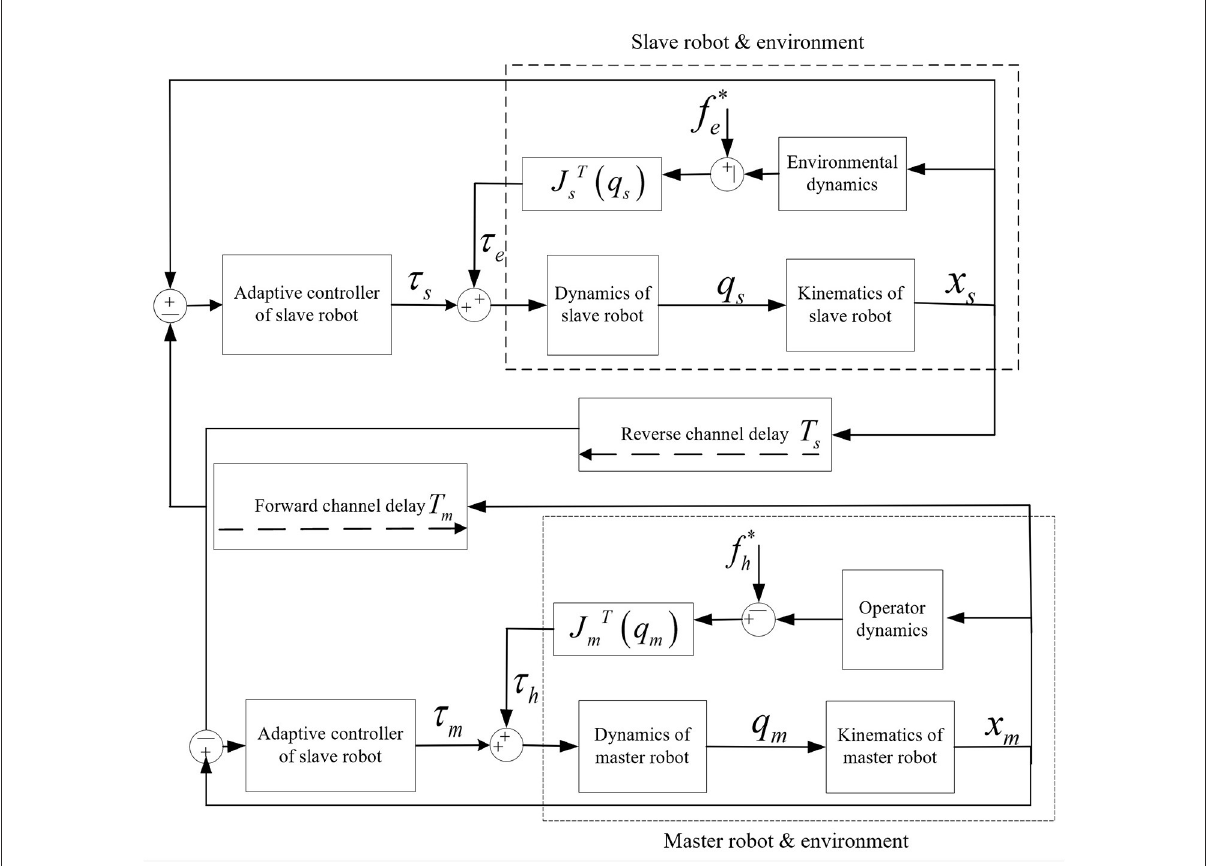
FIGURE2 Adaptive control block diagram of teleoperation system based on position error